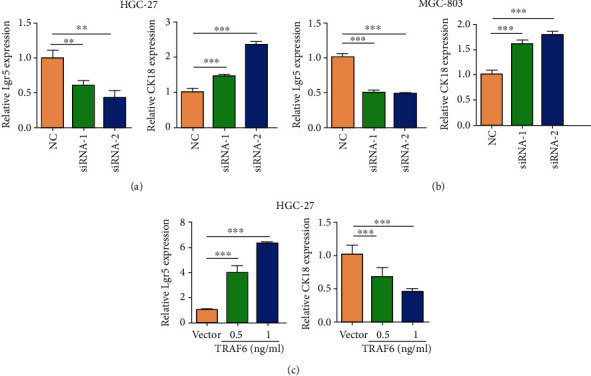
Effect of TRAF6 on differentiation and stemness markers in gastric cancer cells. (a) Real-time PCR analysis for the differentiated gastric epithelial marker CK18 and the cancer stem-like cell marker Lgr5 in NC and TRAF6 siRNA-transfected HGC-27 cells (n = 3, ∗∗p < .005; n = 3, ∗∗∗p < .00001). (b) Real-time PCR assay for the expression of CK18 and Lgr5 in NC and TRAF6 siRNA-transfected MGC-803 cells (n = 3, ∗∗∗p < .001; n = 3, ∗∗∗p < .001). (c) Real-time PCR assay for the expression of Lgr5 and CK18 in vector and TRAF6 plasmid-transfected HGC-27 cells (n = 3, ∗∗∗p < .00001; n = 3, ∗∗∗p < .00001).